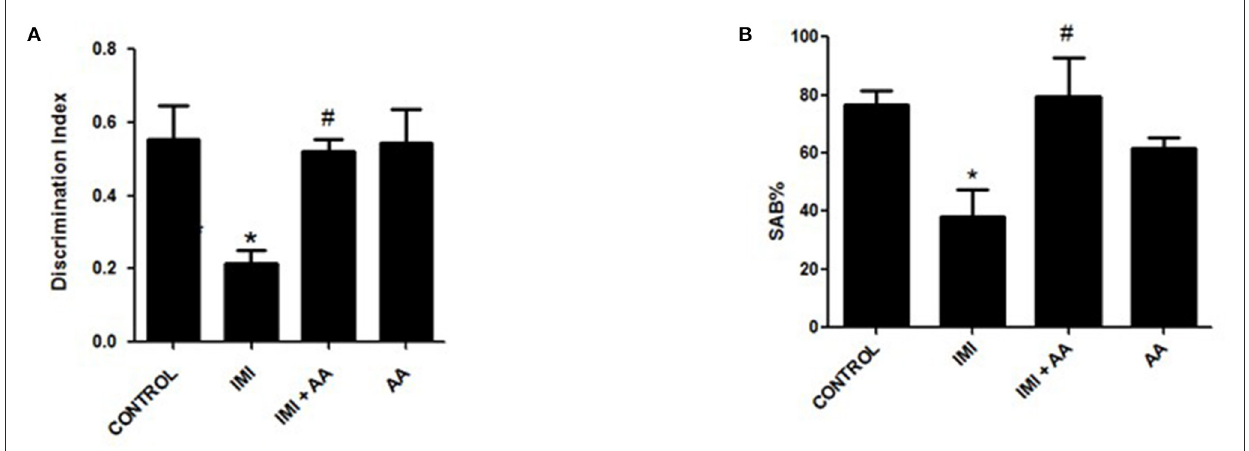
FIGURE1 Y-maze and novel target recognition behavioral tests. Control, IMI, IMI + Ascorbic acid, and Ascorbic acid treated animals were subjected to Y- maze (A) and Novel target recognition test; (B) Discrimination index; after 28 days of IMI daily doses. SAB, Spontaneous Alteration Behavior; DI, Discrimination Index. Data represent mean ± SEM. n = 6/group. *Represents significant values when compared to controls at p < 0.05, # represents significant values when compared to IMI-treated animals at p < 0.05.